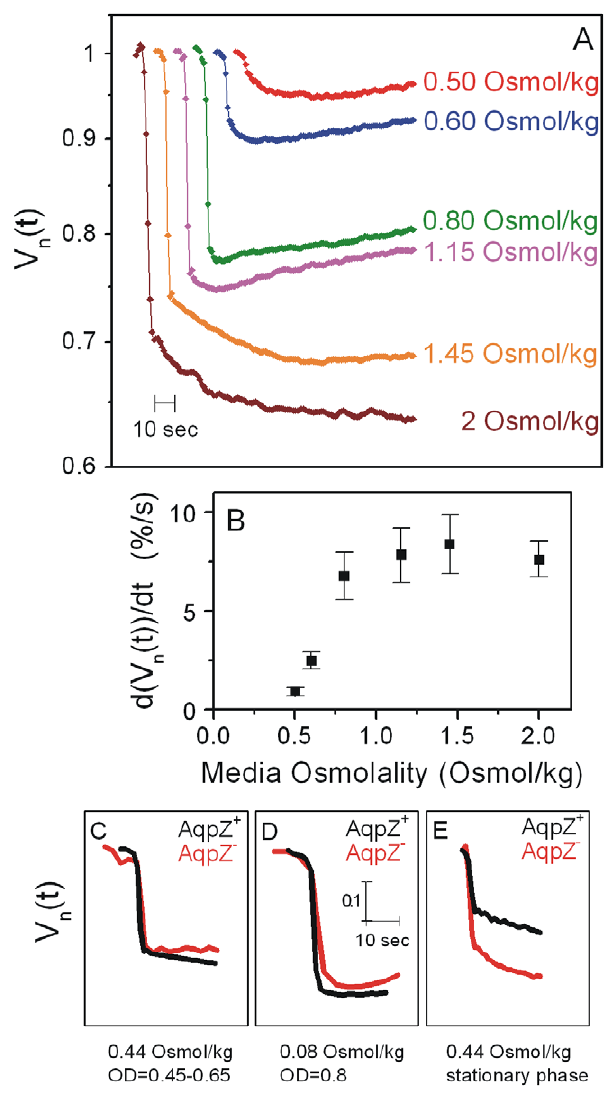
Figure 2. Cell shrinking is fast and doesn’t require AqpZ. (A) Averaged volume traces shown for different shock magnitudes (V n (t)). For each cell in a given data set, the recovery trace was normalized with initial volume and aligned at the time of hyperosmotic shock. The average trace was computed from normalized and aligned data sets as described in the Materials and Methods. For display, the averaged trace for each shock is shifted 10 seconds in time compared to the last one. (B) Rate of initial fast volume reduction dV n (t)/dt for different shock magnitudes. Error bars are standard error of the mean. (C)–(E) Averaged volume traces (V n (t)) aquired at 1 Hz resolution for AqpZ + strain (black) and AqpZ 2 strain (red). (C) Cells were grown in LB (0.44 Osmol/kg) to OD of 0.45–0.65 and transferred to LB with 620 mM sucrose. Approximately 100 cells were used for the AqpZ + strain and 14 cells for the AqpZ 2 strain. (D) Cells were grown in low osmolarity LB (prepared with no NaCl to a final osmolarity of 0.08 Osmol/kg) to OD=0.8 and transferred into low osmolarity LB and 620 mM sucrose. Averaged traces were obtained from 23 cells for ApqZ + and 24 for AqpZ 2 . (D) Cells were grown in LB (0.44 Osmol/kg) for 15 hours and transferred into LB supplemented with 620 mM sucrose. Averaged traces were obtained from 12 cells for AqpZ + and 15 cells for AqpZ 2 .